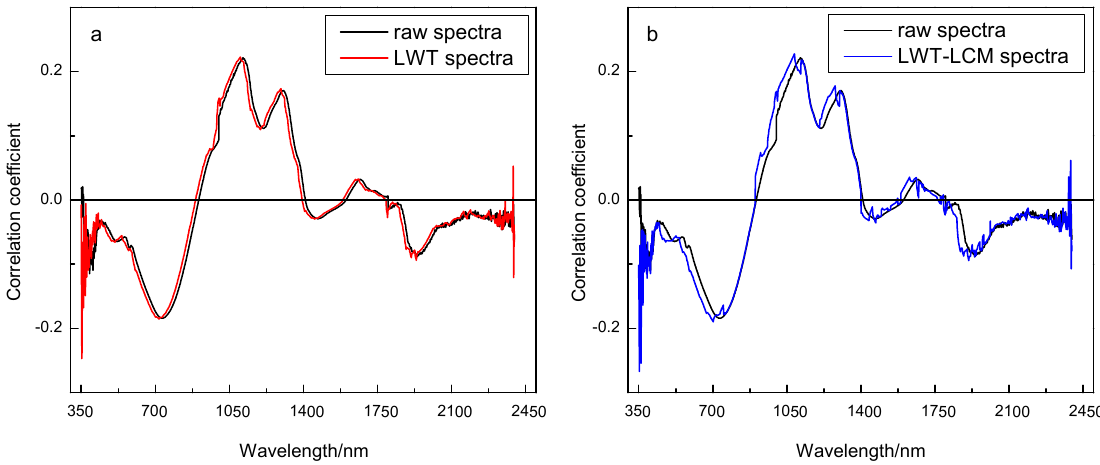
Figure 7. Correlation between corresponding spectra and tracheid length values. ( a ) The comparison of correlation coefficient between raw spectra and spectra pretreated by LWT; ( b ) the comparison of correlation coefficient between raw spectra and spectra pretreated by LWT-LCM.